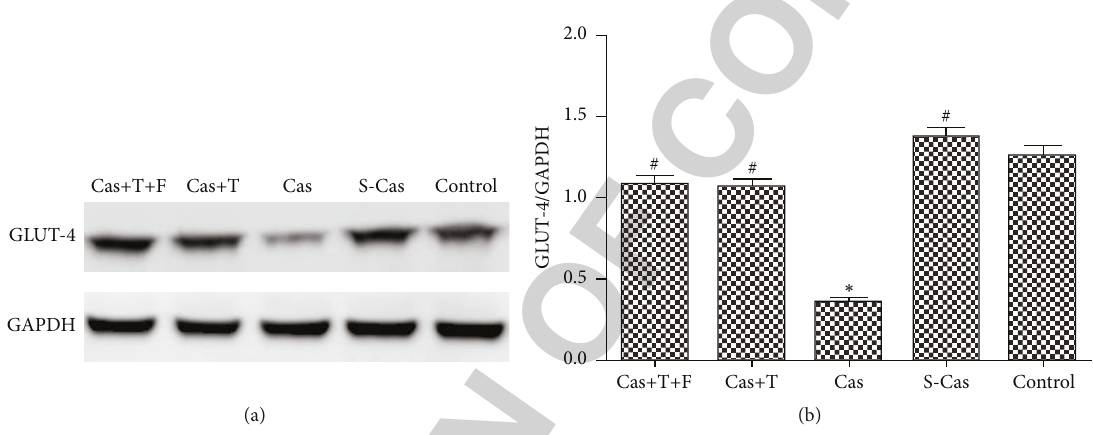
Figure 4: Effects of castration and testosterone on the mRNA expression of GLUT-4. Values are means ± SD; 𝑛 = 3 . S-Cas: sham-castration; Cas: castration; T: testosterone; F: flutamide. # 𝑃 < 0.05 and ## 𝑃 < 0.01 versus Cas.